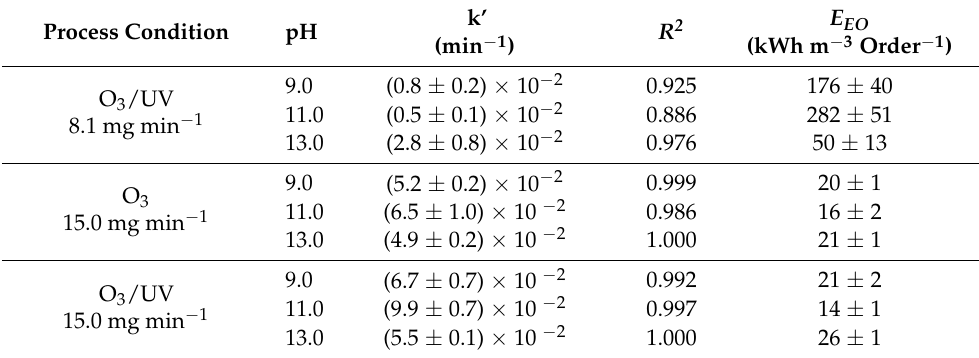
Table 2. Apparent pseudo-first-order rate constants (min − 1 ) and electric energy per order ( E EO , kWh m − 3 order − 1 ) for the O 3 -based